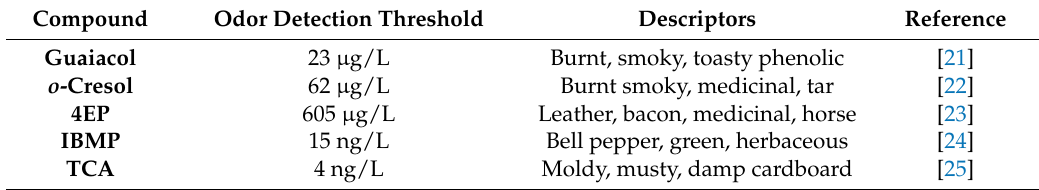
Table 1. Odor Detection Thresholds ( µ g/L) and descriptors for compounds in red